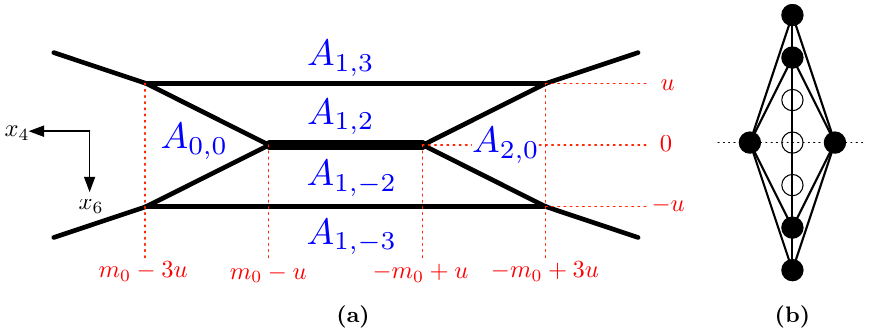
Figure 4. (a): the blue letter A ( m ) indicates the largest A ( m ) in the region. The black solid lines k;l k;l are the boundaries of those regions and give the 5-brane web in the decompacti(cid:12)cation limit of the E 1 curve in Region 1 (3.8). The thick line denotes the coincident 5-branes. (b): the toric-like diagram of the E 1 theory with a triangulation given by the web in (cid:12)gure (a).